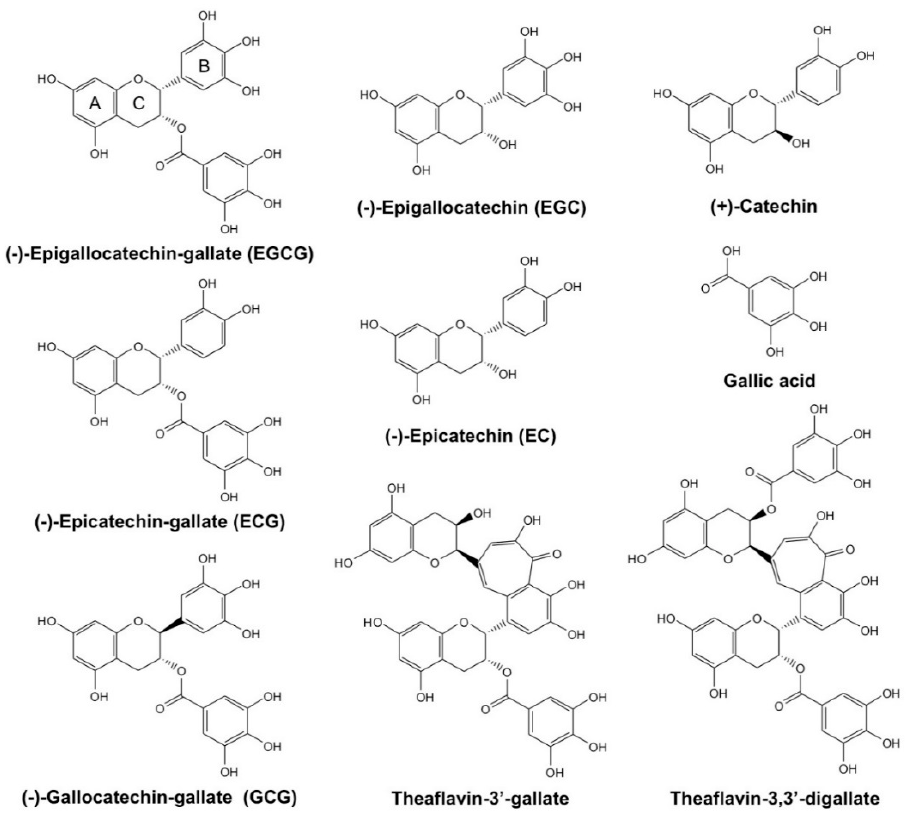
Figure 1. Chemical structures of catechin-related compounds.